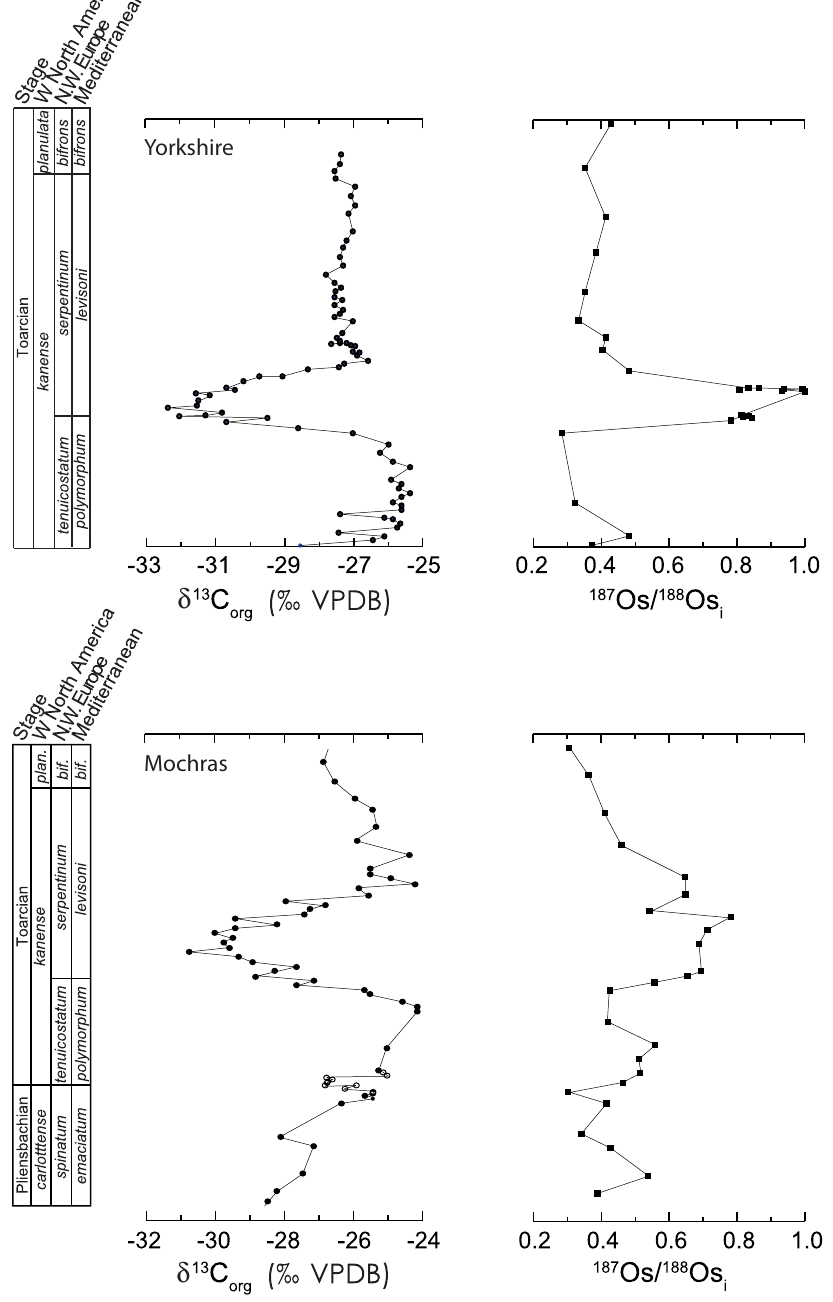
Figure 2. Records of the osmium isotope excursion across the T-OAE CIE from Yorkshire, United Kingdom 20 and the Mochras borehole 23 . The Yorkshire dataset was originally interpreted to represent a 400–800% increase in continental weathering rates 20 ; however, other interpretations suggests that the radiogenic values during the exaratum ammonite subzone were caused by hydrographic restriction 21, 22 . The close palaeogeographic proximity between these two sites, coupled with their significantly different 187 Os/ 188 Os i values suggests a regional influence on 187 Os/ 188 Os sw values in the European epicontinental seaway during the